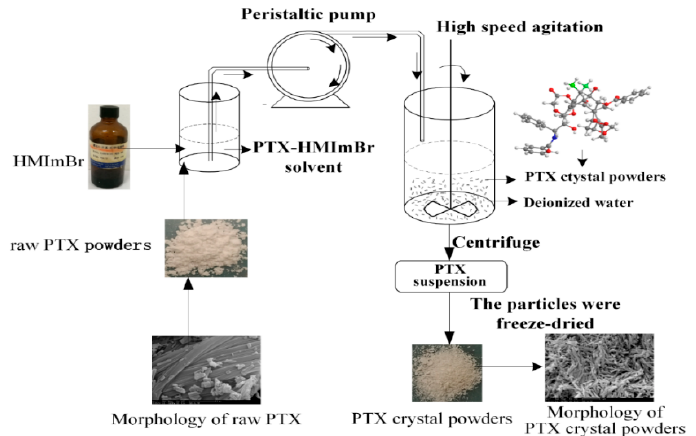
Figure 2. Schematic diagram of the experimental processes to prepare the paclitaxel (PTX) crystal powders.